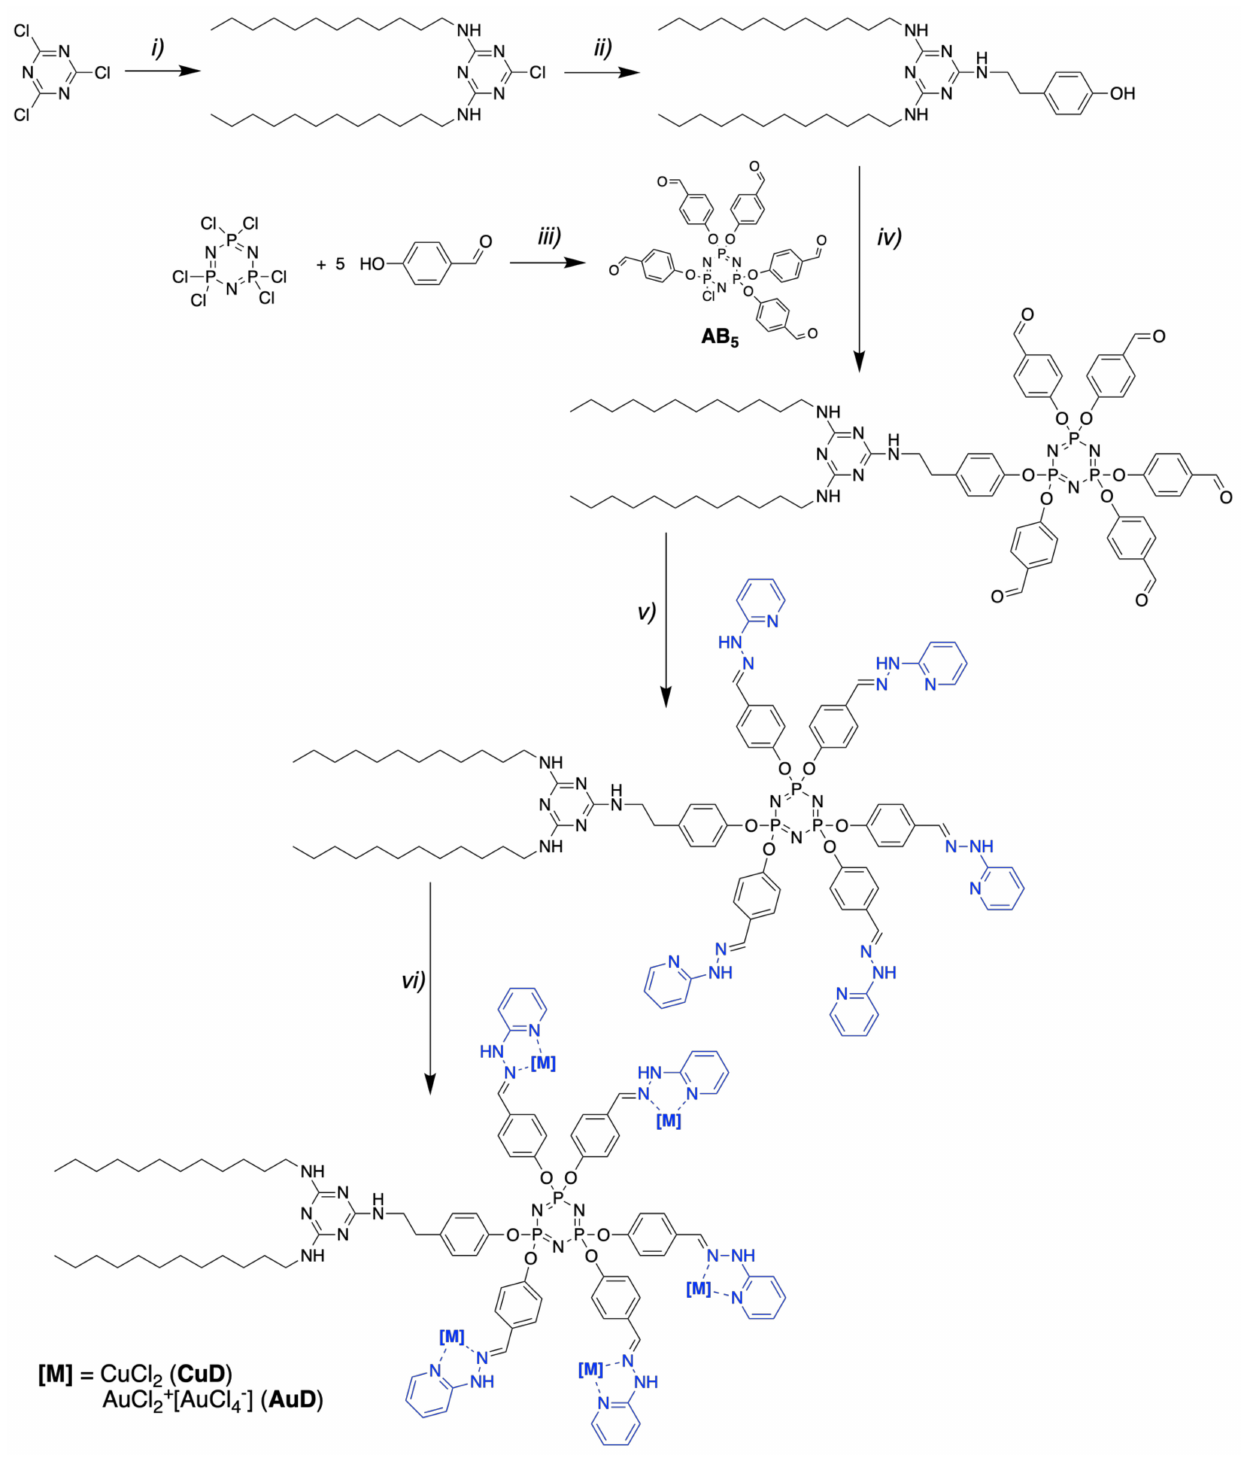
Figure 1. Synthesis of amphiphilic triazine-phosphorus metallodendrons. Conditions: ( i ) n - C 12 H 25 NH 2 , CHCl 3 , NaOH (aq.), 90%; ( ii ) tyramine, toluene, 110 ◦ C, 95%; ( iii ) K 2 CO 3 , acetonitrile, 0 ◦ C, 60%; ( iv ) AB 5 , K 2 CO 3 , acetonitrile, 75 ◦ C, 93%; ( v ) 2-hydrazinopyridine, THF, 60 ◦ C, 85%; ( vi ) CuCl 2 or AuCl 3 , DMF, 60 ◦ C, 54% or